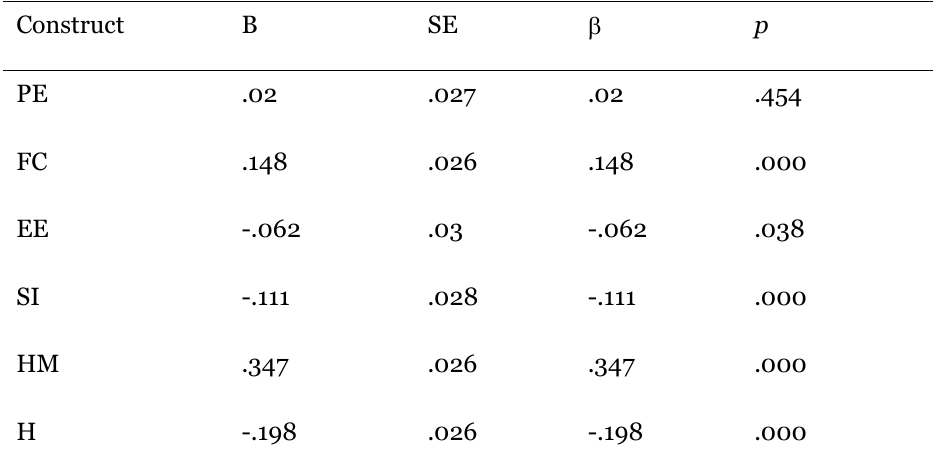
Unstandardized and Standardized Regression Coefficients for the Constructs Entered in the Model Construct